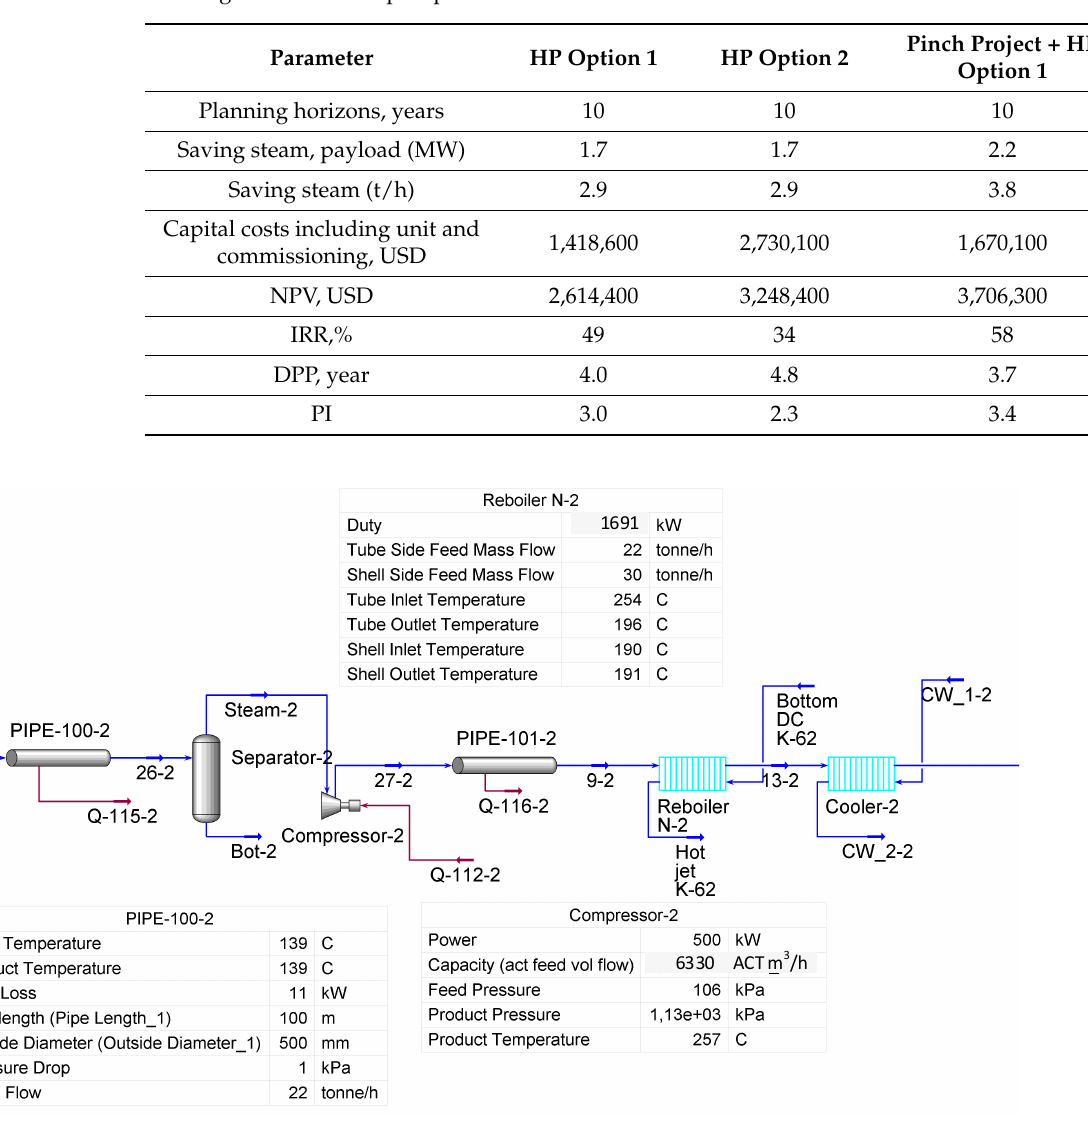
Figure 9. Hysys model of the HP integration with column K-62 (Option No. 2).